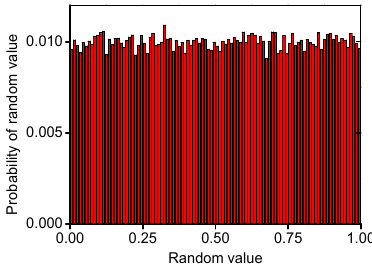
Figure 2. Random values with uniform distribution in the range of [0, 1].